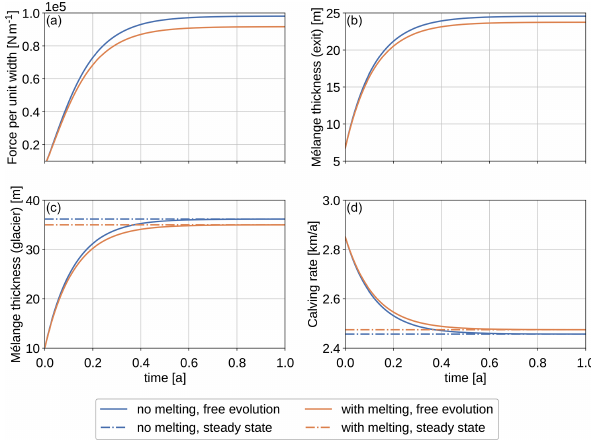
Figure 3. Panels (a) and (b) show the numerical solutions of force per unit width, F(t)/W , and mélange thickness at the embay- ment exit, d( 0 ,t) , given by Eqs. (11)–(14) if mélange length is as- sumed to be constant. Two scenarios are considered: without melt- ing (blue line) and with melting (orange). Panels (c) and (d) show the mélange thickness at the calving front, d(L(t),t) , and the re- sulting buttressed calving rate, C(t) . The solution with free evolu- tion of the mélange geometry (continuous line) is contrasted with the steady-state solution obtained by plugging the mélange length, L(t) , into Eqs. (5) and (6), respectively (dashed line), showing equi- libration of the mélange in less than a